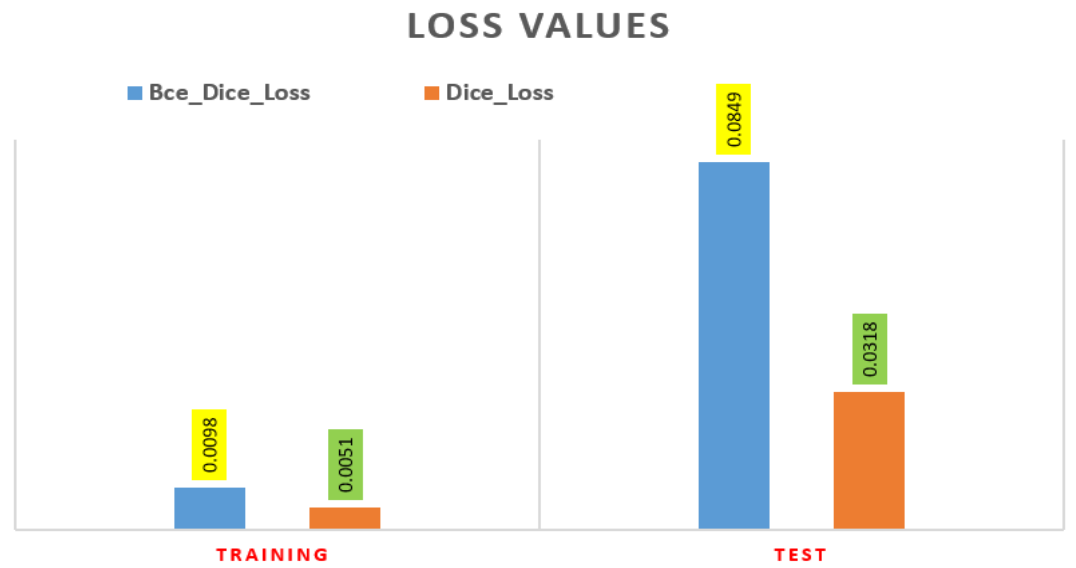
Figure 9. The Error Loss of Dice Loss and BCE_Dice-Loss on training and test dataset.